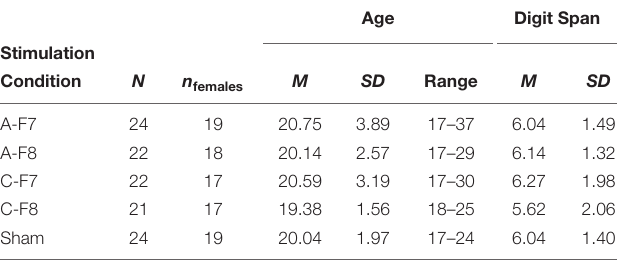
TABLE 1 | Sample characteristics.